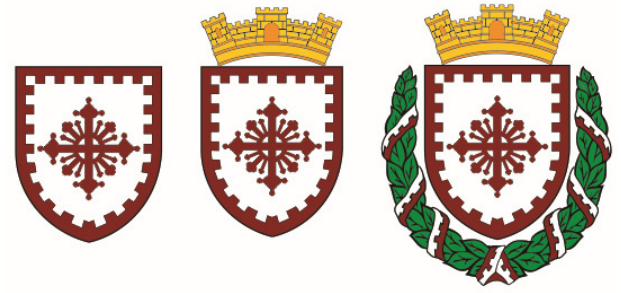
Figure 17. Achievements of Radovish.